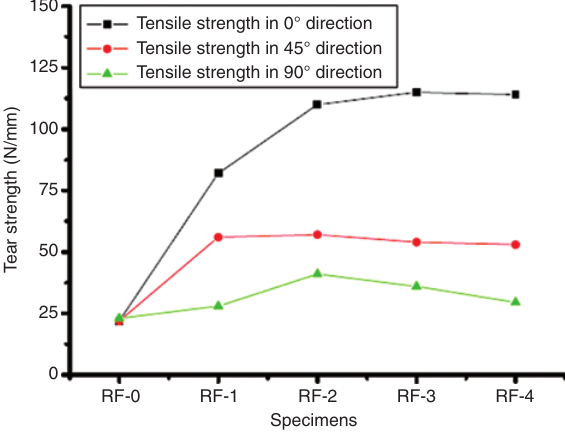
Figure 7: Tear strength of CR reinforced with different numbers of polyester tire cord layers at the 0 ° , 45 ° , and 90 ° directions.